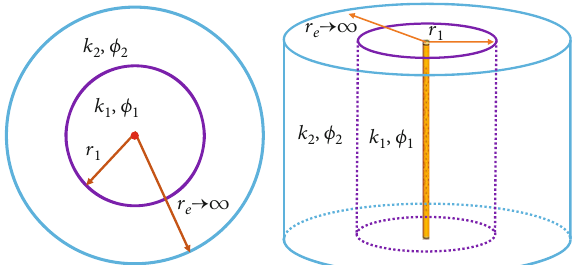
Figure 1: Physical model of vertical well producing in composite gas reservoir.